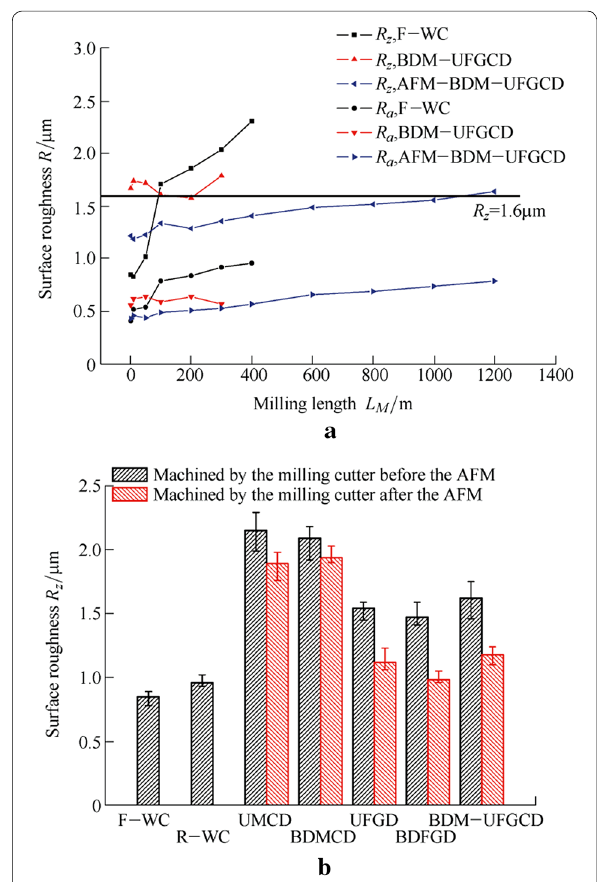
Figure 9 a Variations of both the R a and R z values of workpieces machined by three typical specimens with the milling length and b corresponding R z values of workpieces machined by all the specimens at initial stages of milling